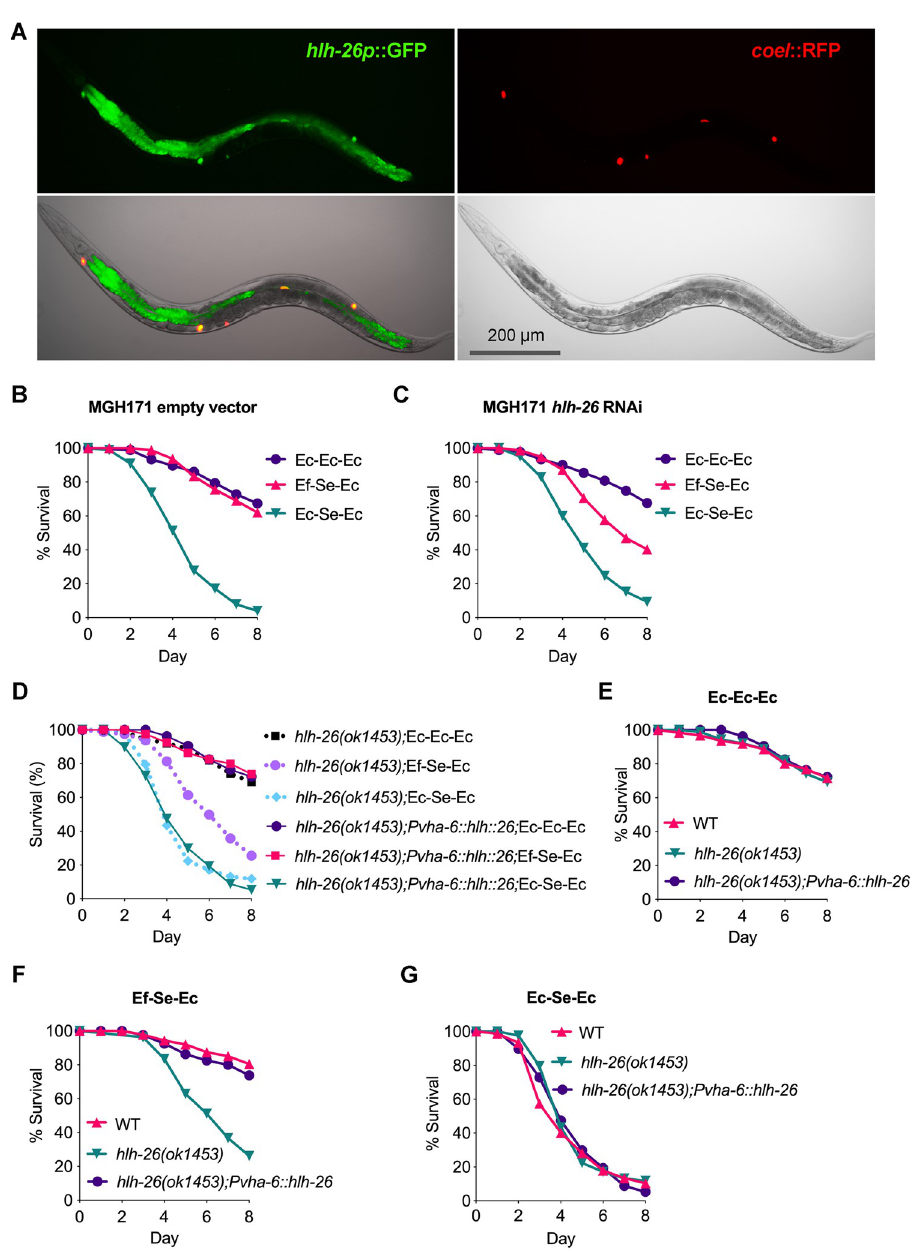
Fig 3. HLH-26 is expressed in the intestine. (A) hlh-26p :: gfp expression in young adult transgenic worms assessed by fluorescence microscopy (25 × ). coel :: rfp was used as the coinjection marker. Survival curves assaying E . faecium – mediated protection in the intestine-specific RNAi strain MGH171 feeding on HT115 expressing (B) empty vector or (C) hlh-26 RNAi animals. (D) Comparison of E . faecium –mediated protection between hlh-26(ok1453) animals and hlh-26(ok1453); Pvha-6 :: hlh-26 rescue animals. hlh-26(ok1453) ; Ec-Ec-Ec versus hlh-26(ok1453); Pvha-6 :: hlh-26 ;Ec-Ec- Ec, P = NS; hlh-26(ok1453) ; Ef-Se-Ec versus hlh-26(ok1453);Pvha-6 :: hlh-26 ; Ef-Se-Ec, P < 0.0001; hlh-26(ok1453) ; Ec- Se-Ec versus hlh-26(ok1453);Pvha-6 :: hlh-26 ;Ec-Se-Ec, P = NS. (E) WT, hlh-26(ok1453) , and hlh-26(ok1453); Pvha-6 :: hlh-26 animals were grown with E . coli-E . coli-E . coli treatment and scored for survival. WT animals versus hlh-26 (ok1453) , P = NS; hlh-26(ok1453); Pvha-6 :: hlh-26 , P = NS. (F) WT, hlh-26(ok1453) , and hlh-26(ok1453); Pvha-6 :: hlh-26 animals were grown with E . faecium-S . enterica-E . coli treatment and scored for survival. WT animals versus hlh-26 (ok1453) , P = NS; hlh-26(ok1453); Pvha-6 :: hlh-26 , P < 0.0001. hlh-26(ok1453) animals versus hlh-26(ok1453); Pvha-6 :: hlh26 , P < 0.0001. (G) WT, hlh-26(ok1453) , and hlh-26(ok1453); Pvha-6 :: hlh-26 animals were grown with E . coli-S . enterica-E . coli treatment and scored for survival. WT animals versus hlh-26(ok1453) , P = NS; hlh-26(ok1453); Pvha-6 :: hlh-26 , P = NS. The data underlying all the graphs shown in the figure can be found in S1 Data. NS, nonsignificant; RNAi, RNAi interference; WT,